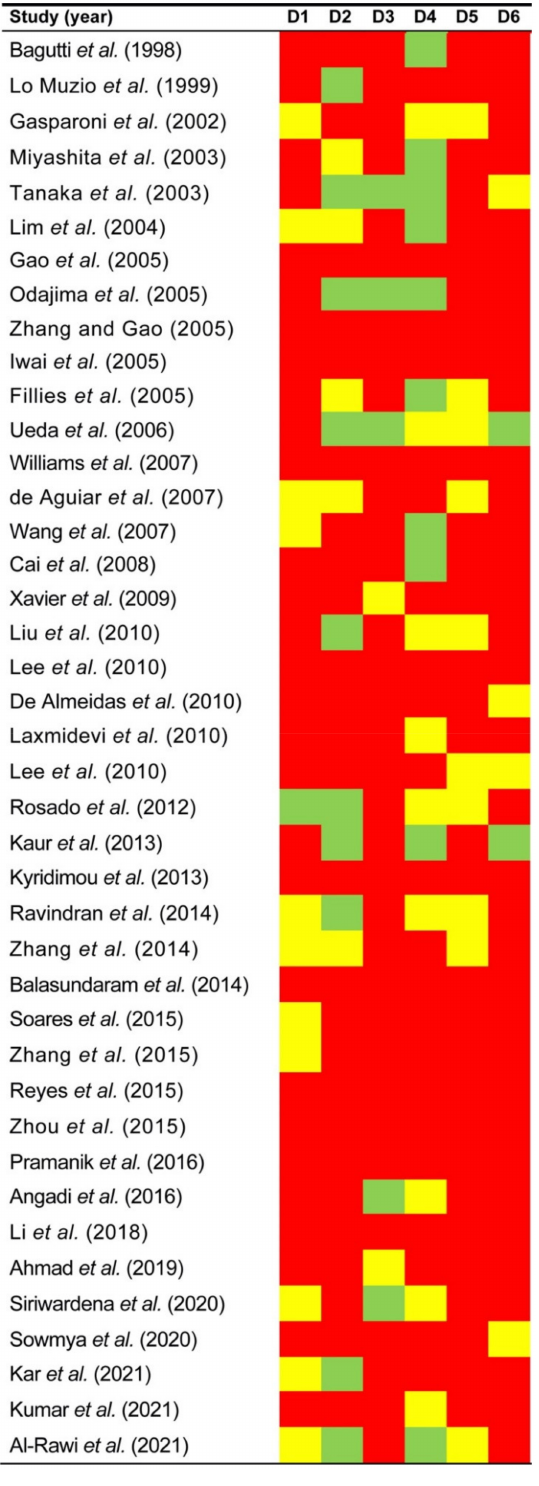
Figure 2. Evaluation of the risk of bias of primary-level studies [12,38–77] using the Quality in Prognosis Studies (QUIPS) tool. Green, low risk of potential bias; yellow, moderate; red,